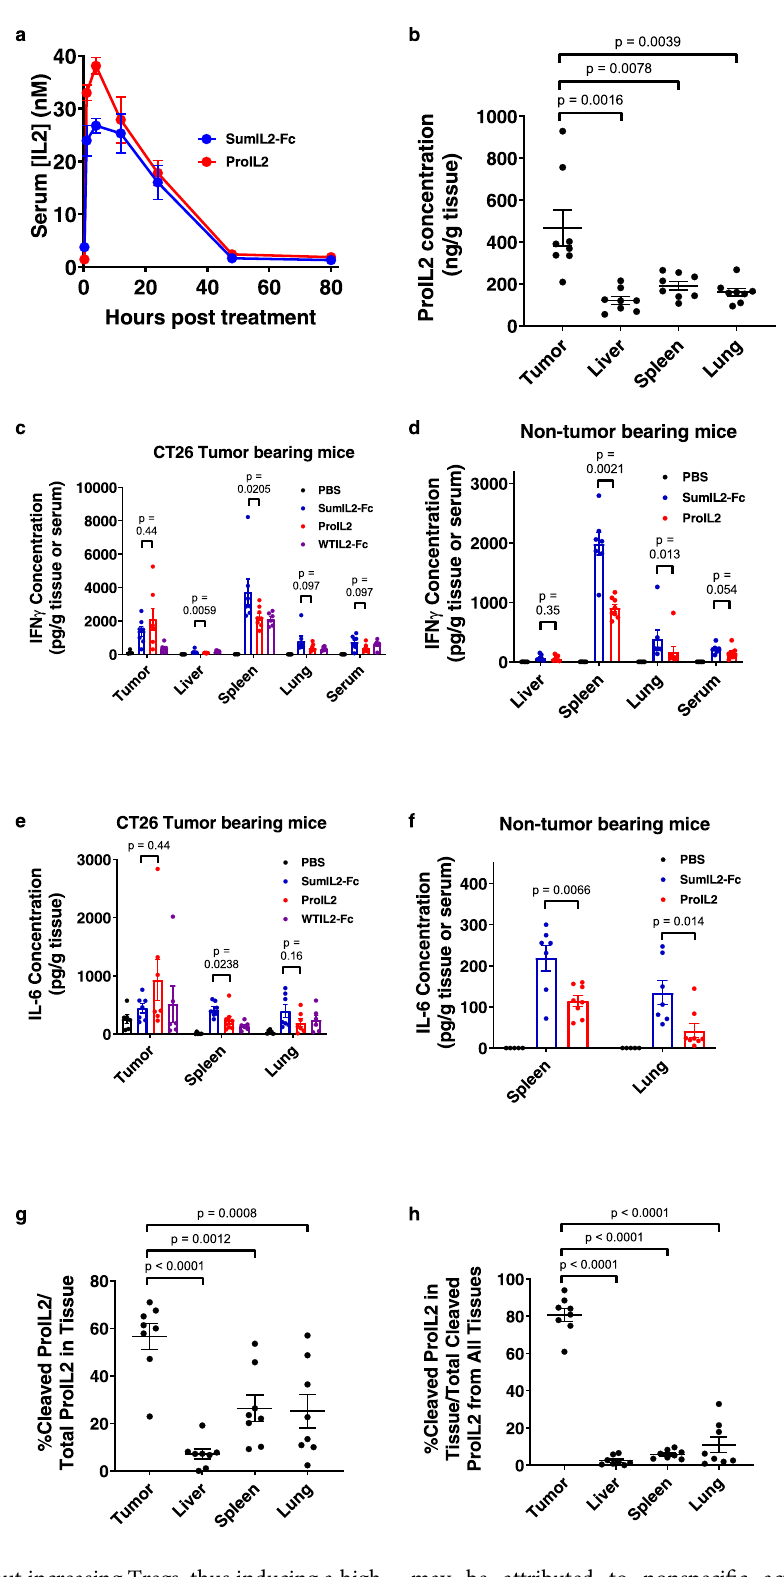
may be attributed to nonspeci fi c activation of CTLs in the periphery that ultimately circulate to the tumor and thus tumor- draining lymph nodes. These results suggest that ProIL2 induces a strong activating phenotype in the tumor microenvironment (TME), particularly a tumor-antigen-speci fi c phenotype. However, ProIL2 and SumIL2-Fc both decreased the frequency of dendritic cells in the tumor (Supplementary Fig. 7k). These in